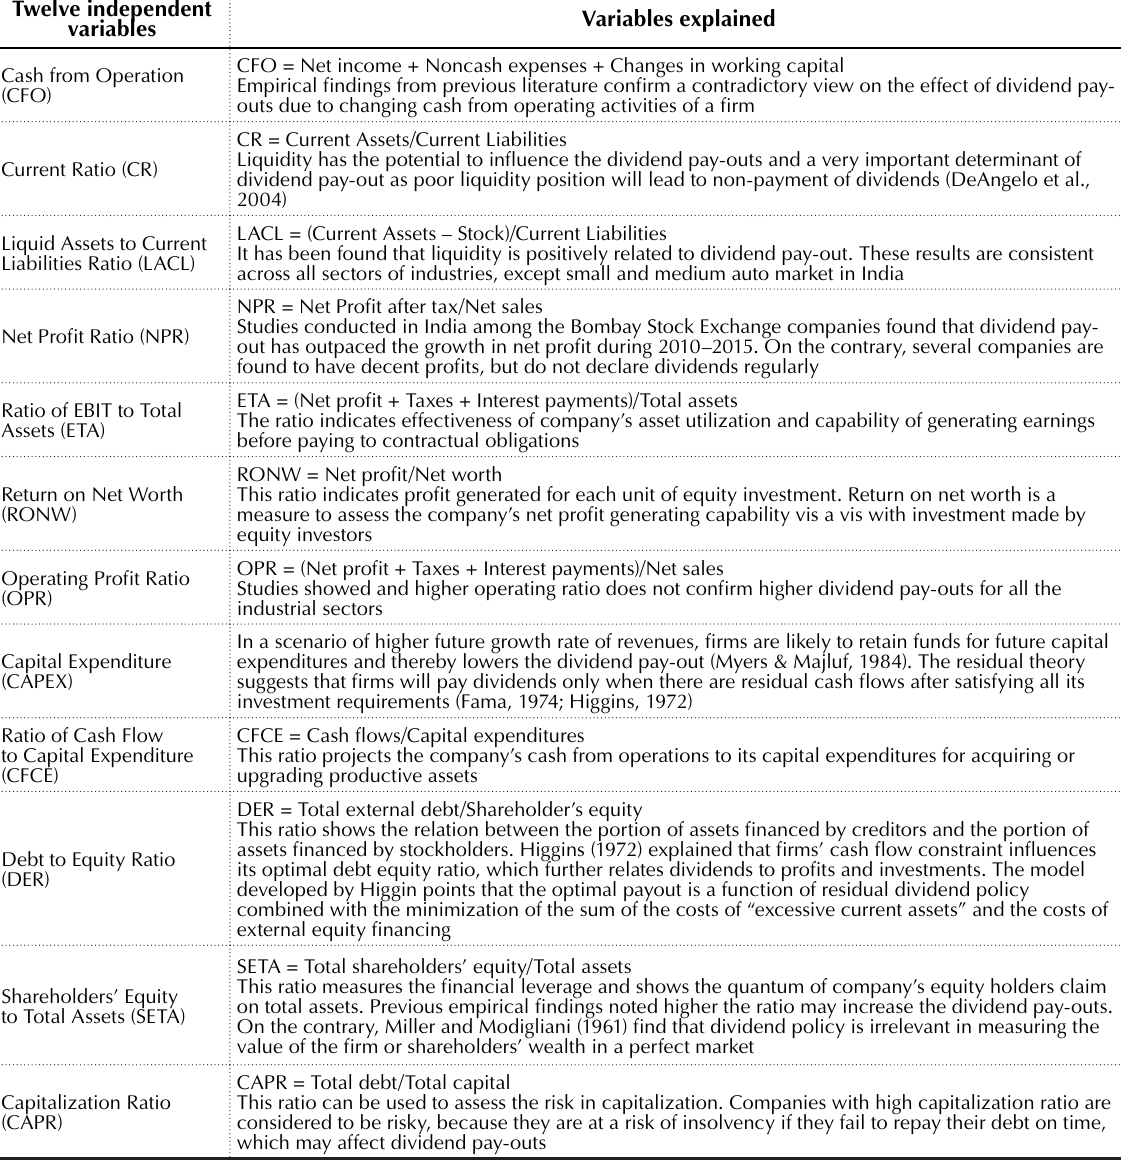
Source: Developed by the